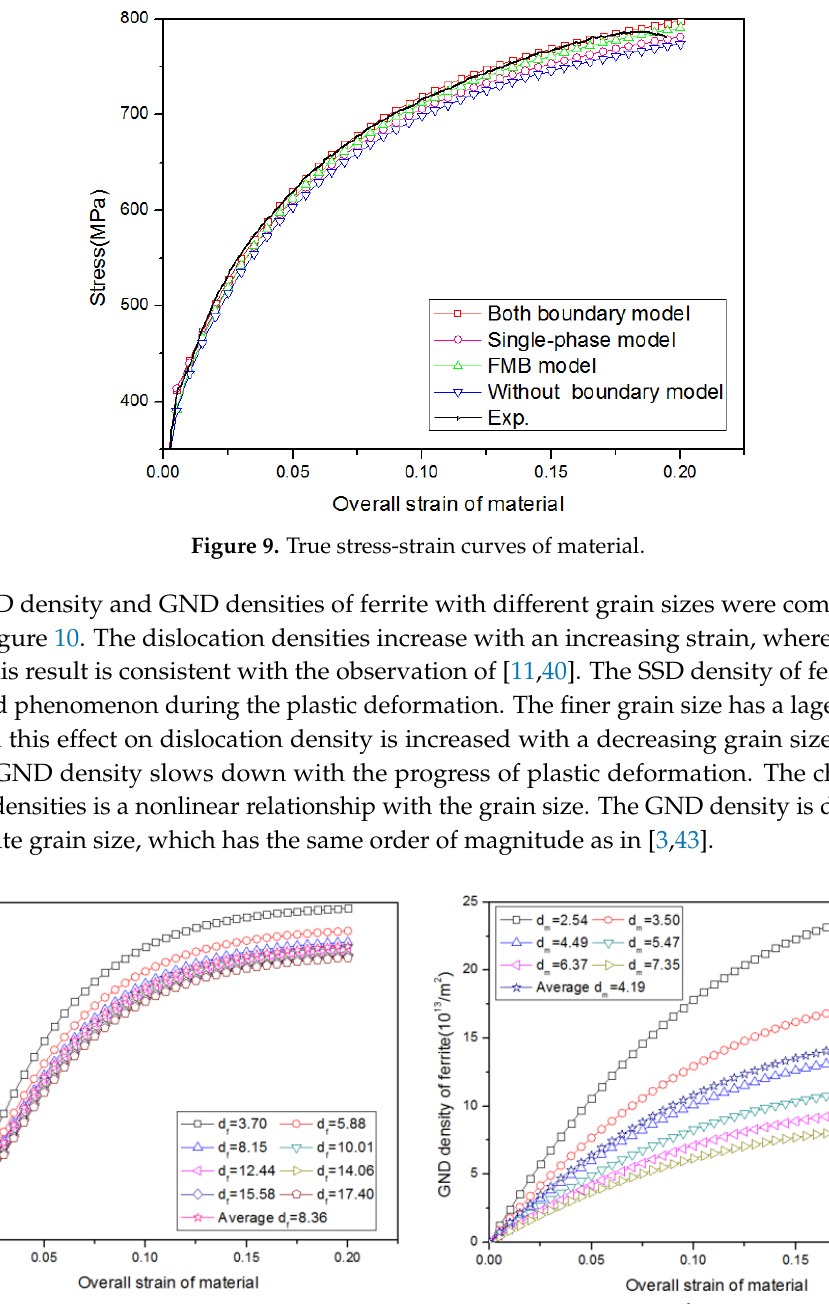
Figure 10. Dislocation density: ( a ) SSD density, ( b ) GND density.